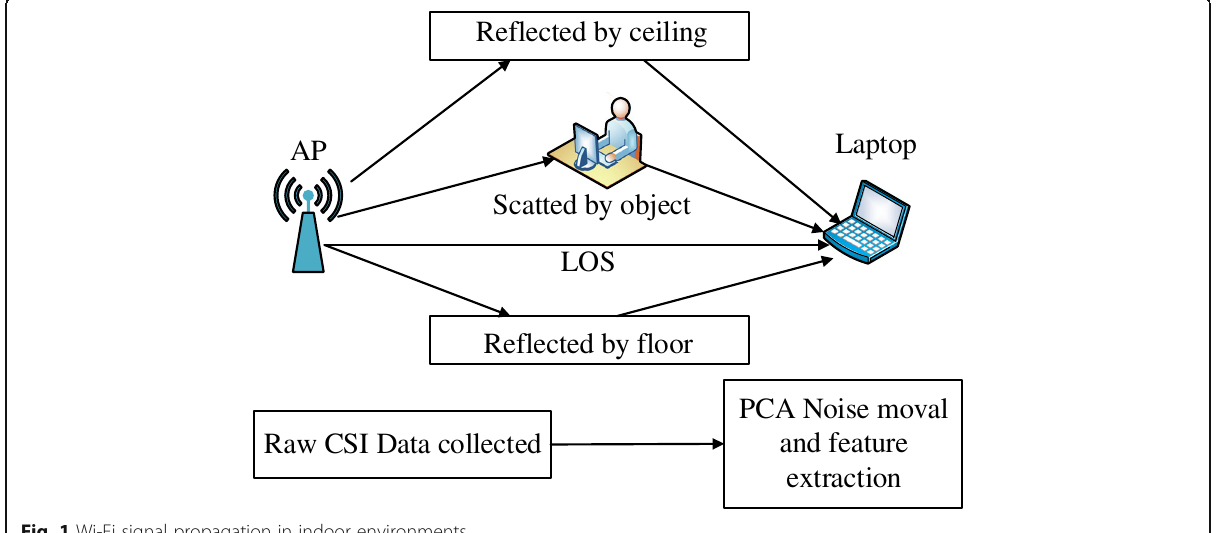
Fig. 1 Wi-Fi signal propagation in indoor